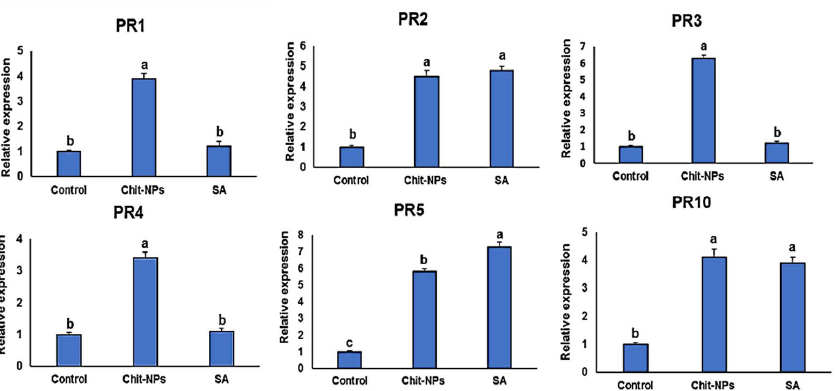
Figure 9. Effect of chitosan nanoparticles (Chit-NPs) and salicylic acid (SA) on the relative transcrip- tion levels of PR1-PR5 and PR10 genes in infected wheat plants at 1 day after treatment (0-day post inoculation). The letters (a, b and c) denote significant difference.